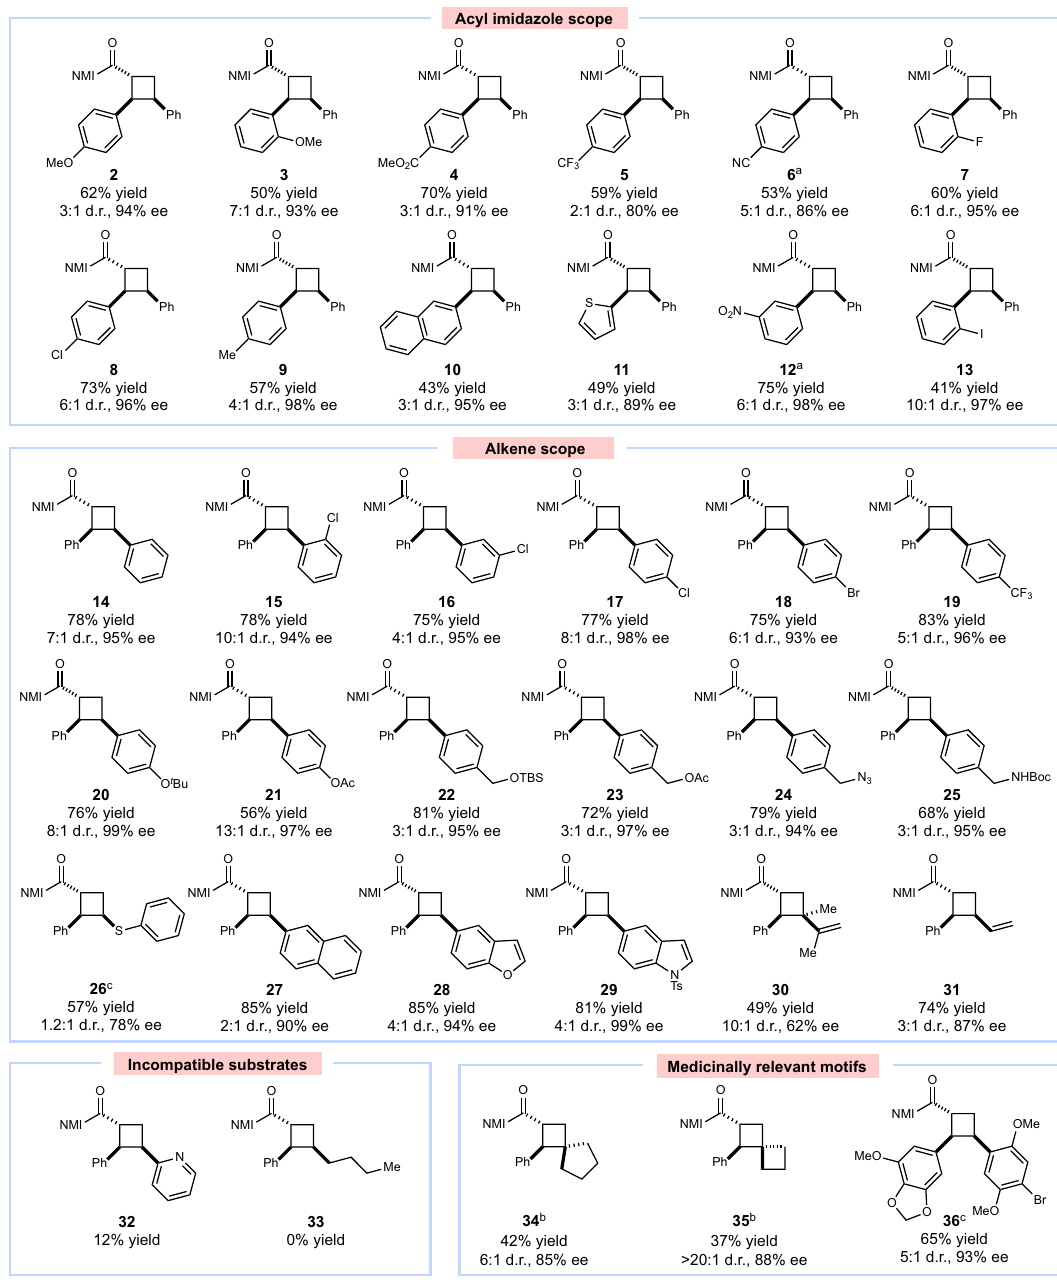
Fig. 3 Scope studies. Reactions conducted using 1 equiv 2-acyl imidazole, 10 equiv alkene, 20 mol% AC-3 in toluene, irradiating for 14 h with a Kessil H150 LED unless otherwise noted. Yields represent the isolated yield of both diastereomers. Enantiomeric excess of the major diastereomer determined by chiral HPLC. a Conducted for 24 h. b Conducted with 40 mol% acid catalyst AC-3 . c Conducted in CH 2 Cl 2